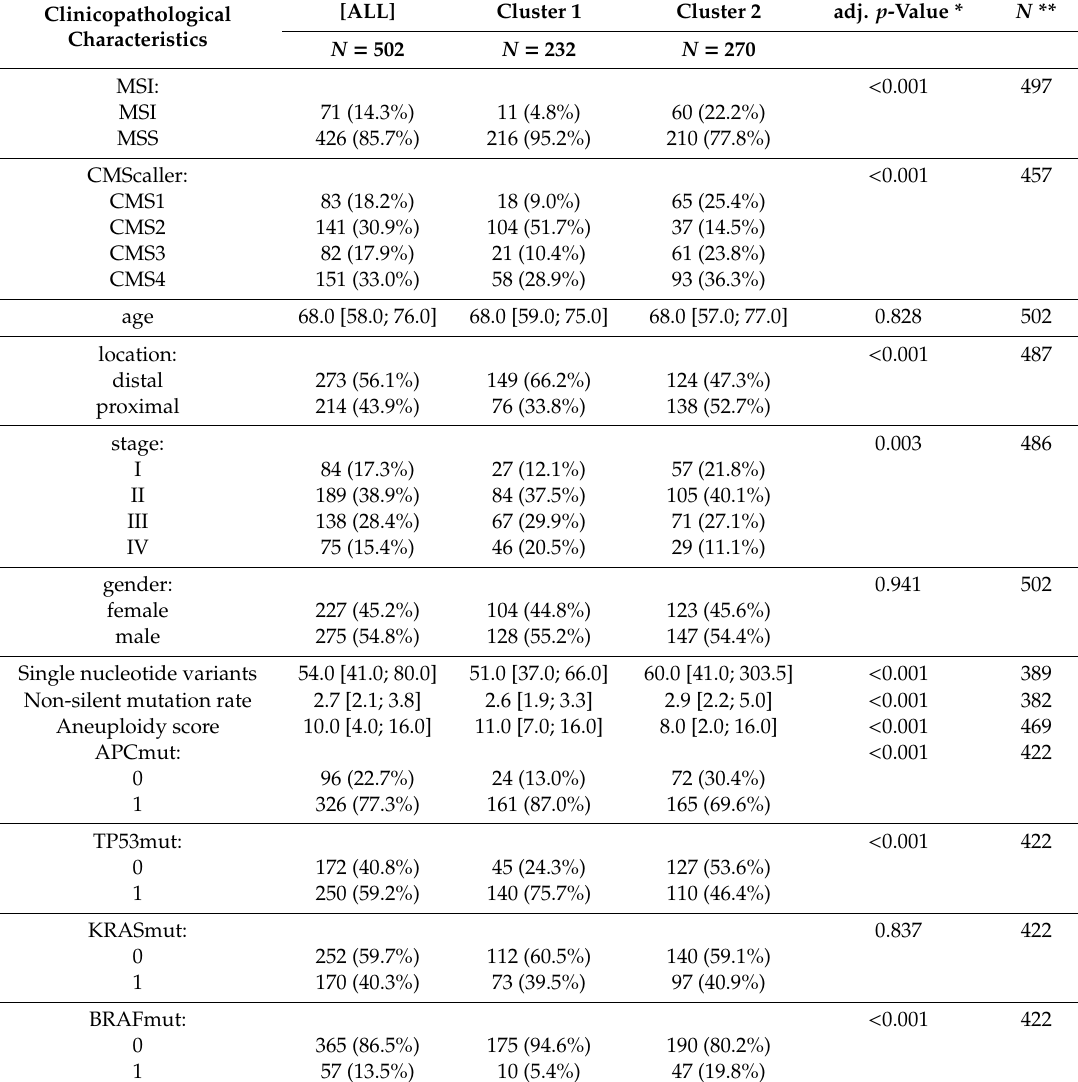
Molecular characteristics of autophagy clusters (The Cancer Genome Atlas (TCGA) RNA-seq